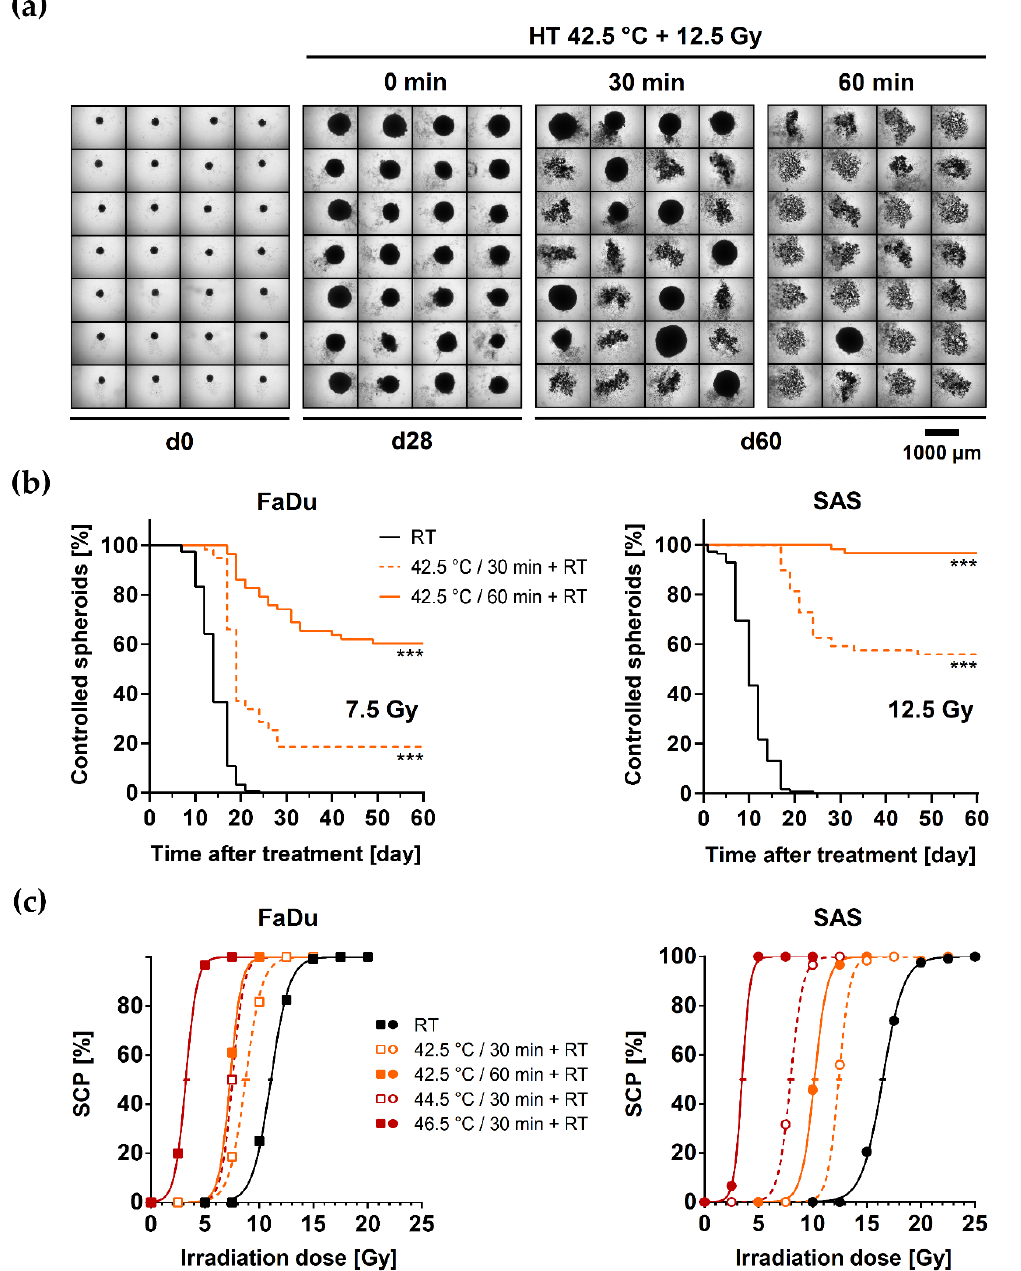
Figure 2. HT efficiently sensitizes both HNSCC spheroid types to single dose irradiation: ( a ) Representative images of 28 SAS spheroids exposed for 30 min or 60 min to 42.5 °C followed by 12.5 Gy single dose irradiation illustrate the radiosensitizing effect of different doses of HT; spheroids before treatment and without (0 min) HT pre-exposure are documented for comparison. ( b ) Proportions of controlled (non-regrown) FaDu and SAS spheroids documented as function of time post-treatment when exposed for 0, 30, or 60 min to 42.5 °C HT before single dose irradiation (FaDu—7.5 Gy; SAS—12.5 Gy); N = 2; ∑ n ≥ 56 spheroids per condition; *** p < 0.001 as assessed with the Log-rank (Mantel-Cox) test for survival curves based on the pooled data. ( c ) Spheroid control dose response curves after HT pre-exposure and 0–25 Gy single dose irradiation; the proportion of spheroids that lost regrowth capacity (spheroid control probability, SCP) is recorded as a function of the irradiation dose. Every data point in each HT treatment arm represents the SCP of ∑ n ≥ 56 individual spheroids from N = 2 independent experiments monitored up to 60 days post-treatment ( ≥ 560–620 spheroids per SCP curve). Horizontal bars present the 95% confidence interval of the SCD 50 (spheroid control dose 50%).